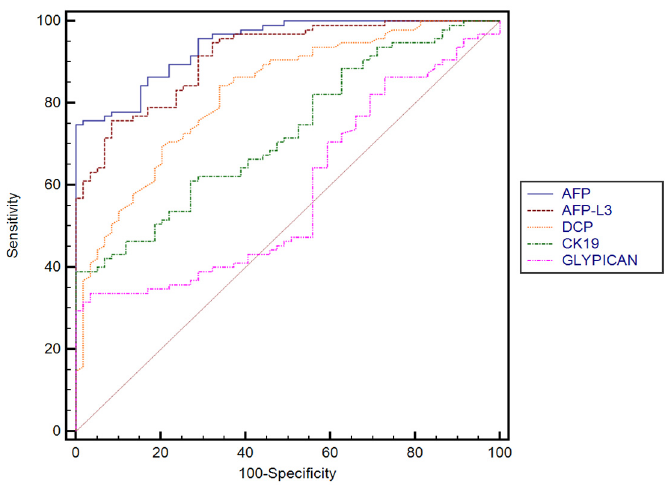
Figure 2. Comparison between receiver operating characteristics for different serum biomarkers.